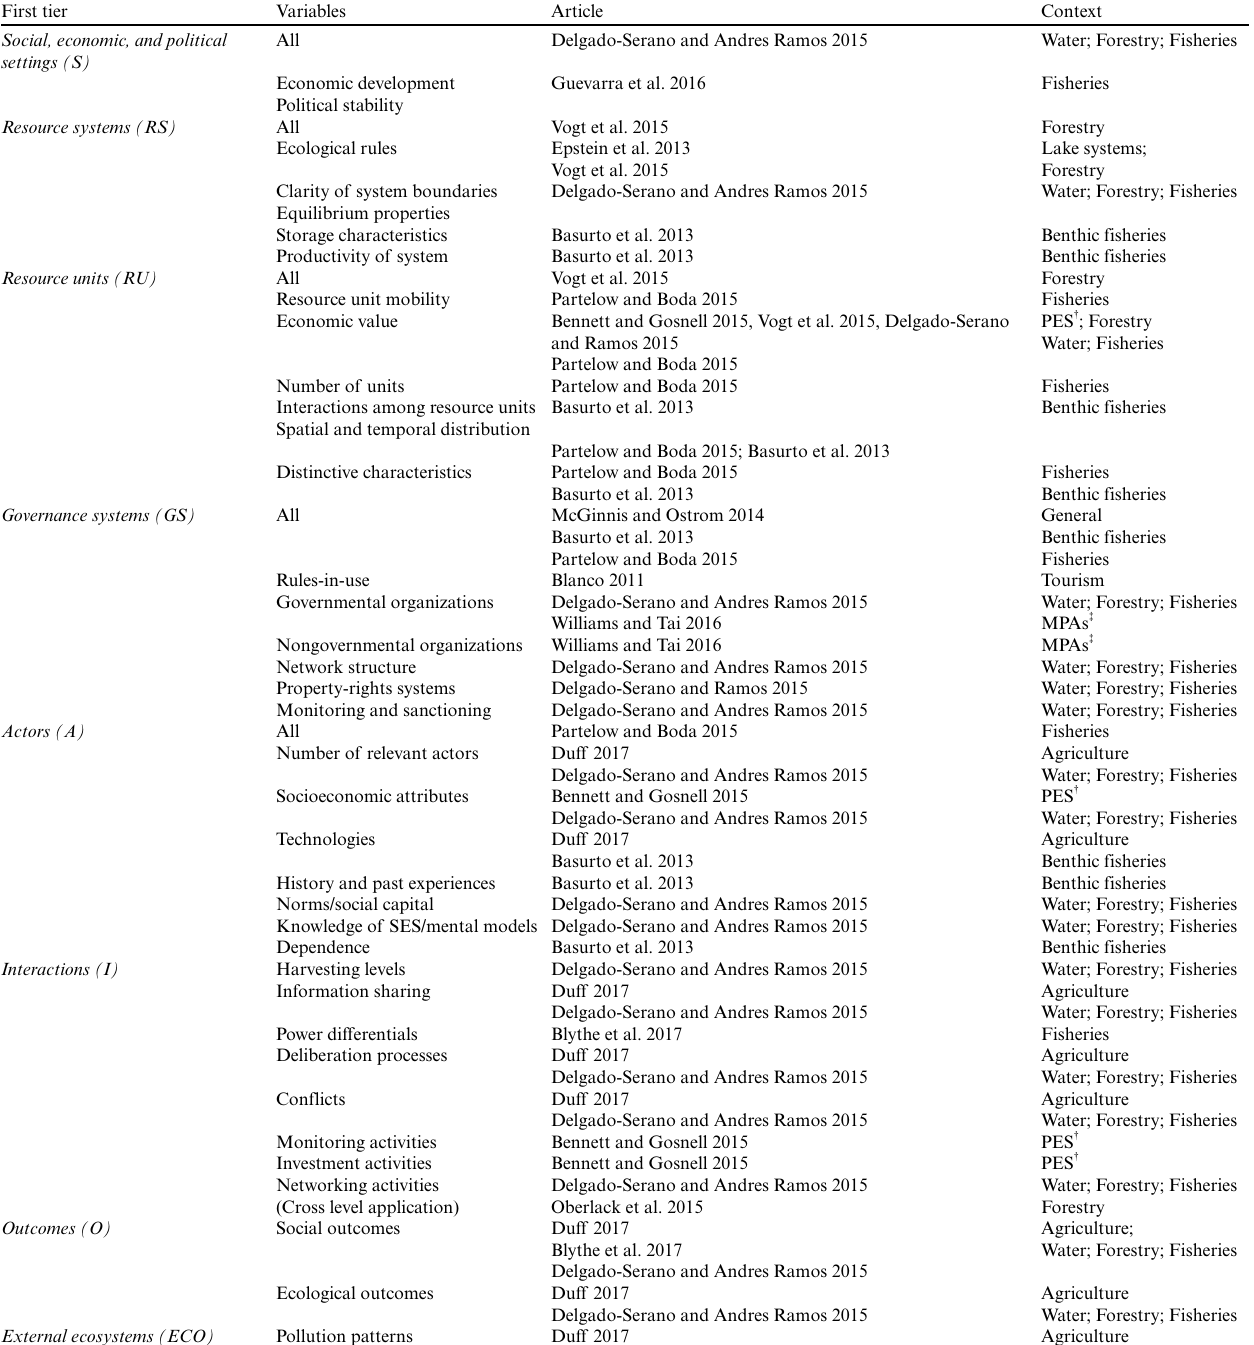
Table 5. Articles suggesting modifications to variables of the social-ecological systems framework. The table is organized by the variables, articles, and context. Many articles suggest modifications, however, this is not an exhaustive list. Most articles focus on many variables, but only suggest modifications to a few. “All” refers to all second-tier variables within the first-tier